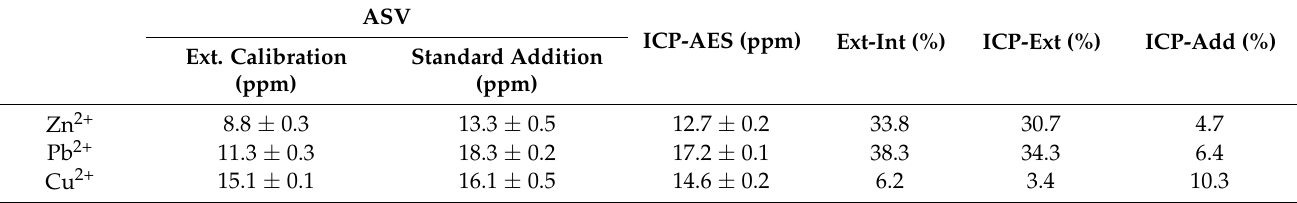
Table 2. Metal concentration values (ppm) determined for one of the soil samples by ASV, considering both external calibration and standard addition methods, and ICP-AES. Average ± standard deviation ( n =